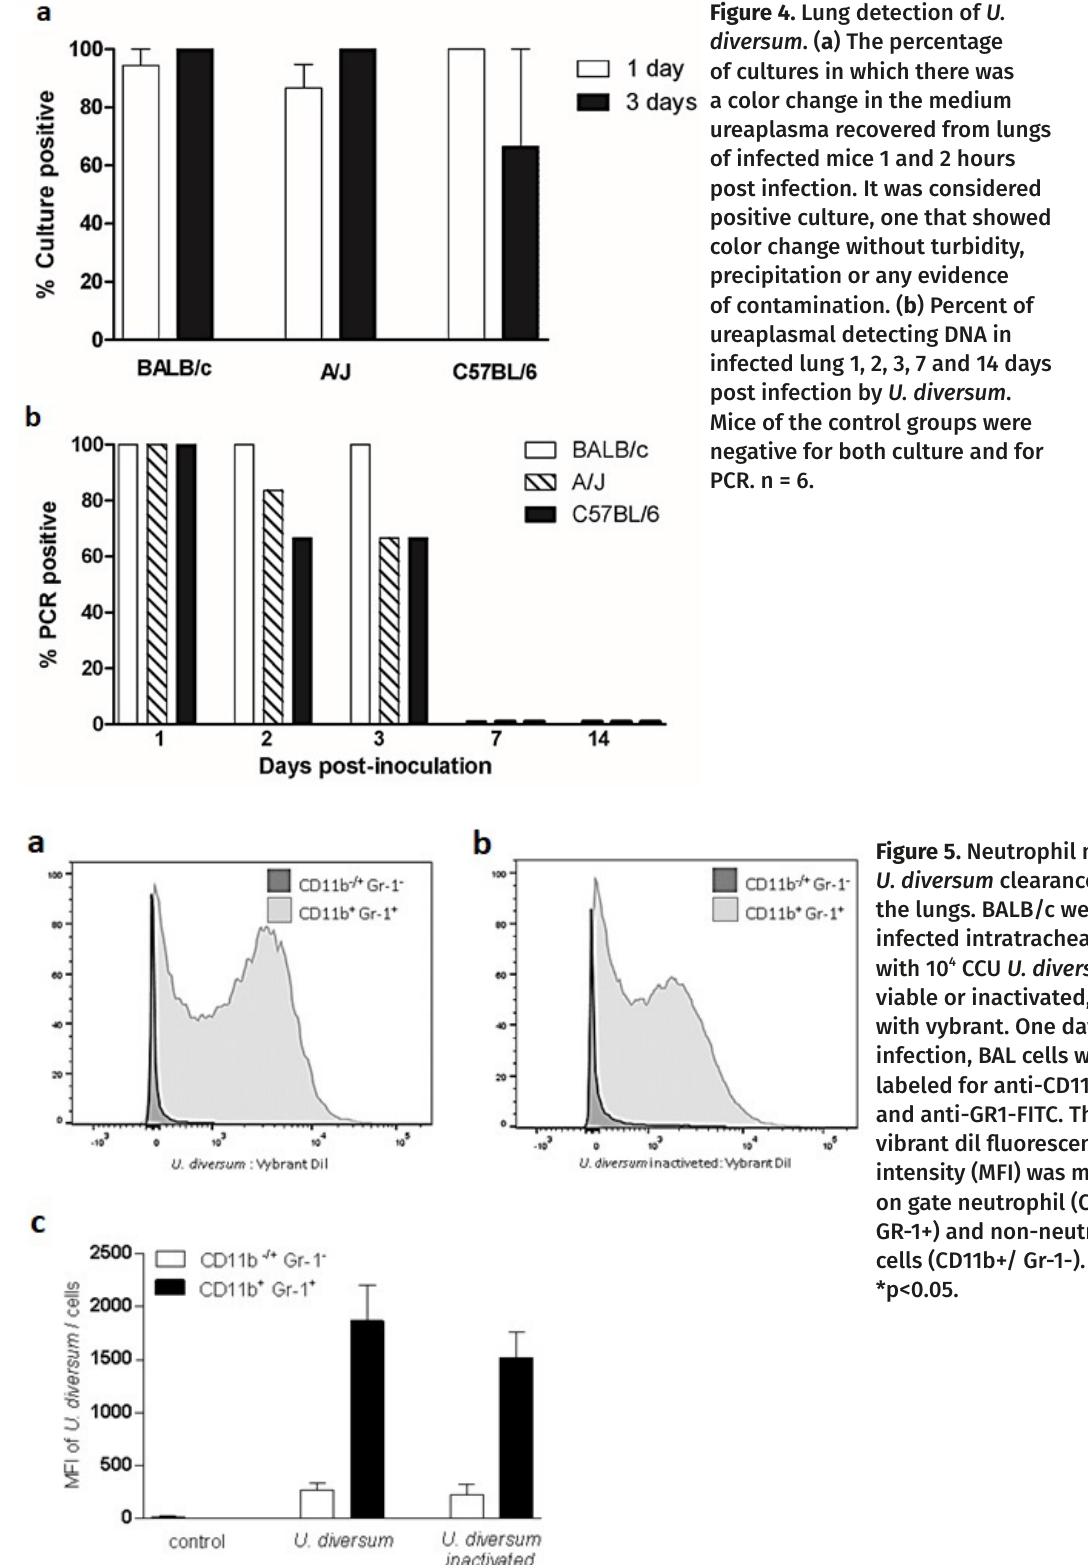
and anti-GR1-FITC. The mean